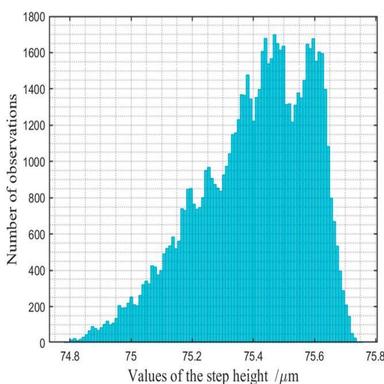
Distributions of the values of the step height calculated by the Centroid-Normal method in Experiment 1.